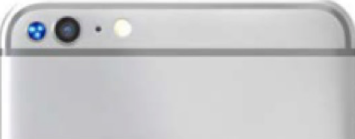
Figure 2. Proposed back light on mobile phones to notify bystanders of recording or live-streaming.